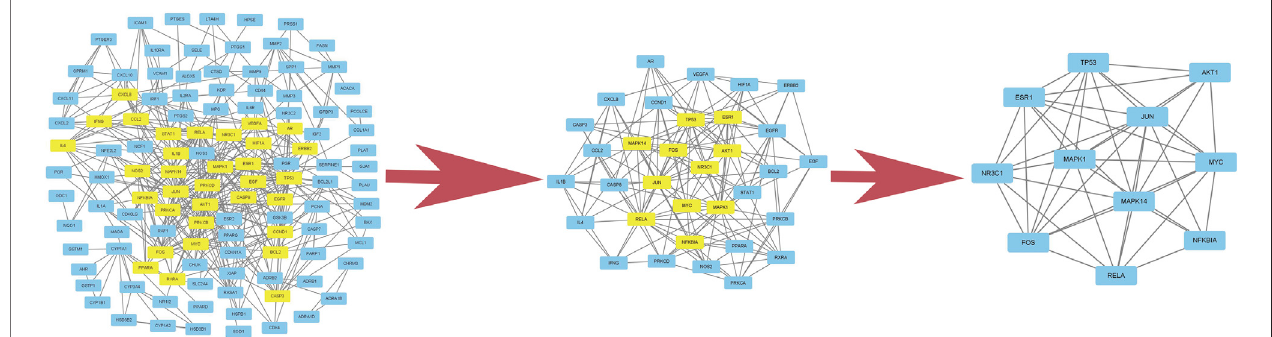
FIGURE 3 | Hub genes of the